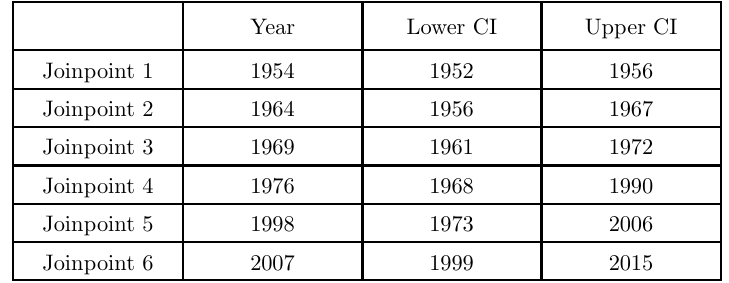
Table 1. Selected joinpoints (CI is 95% confidence interval)